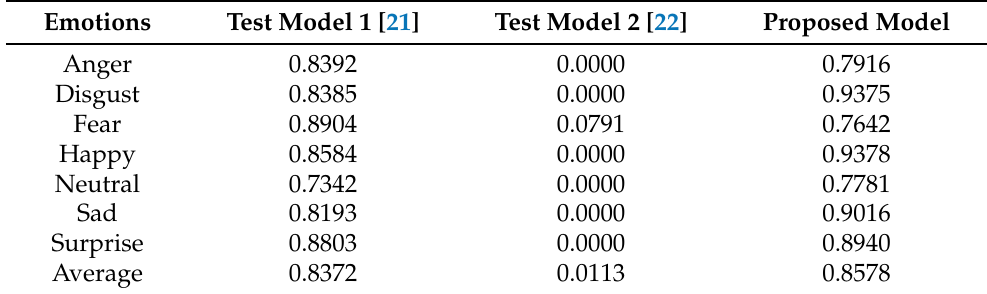
Table 27. Precision comparison between all three models with respect to observation 1 of Experiment 1 with epochs 10.